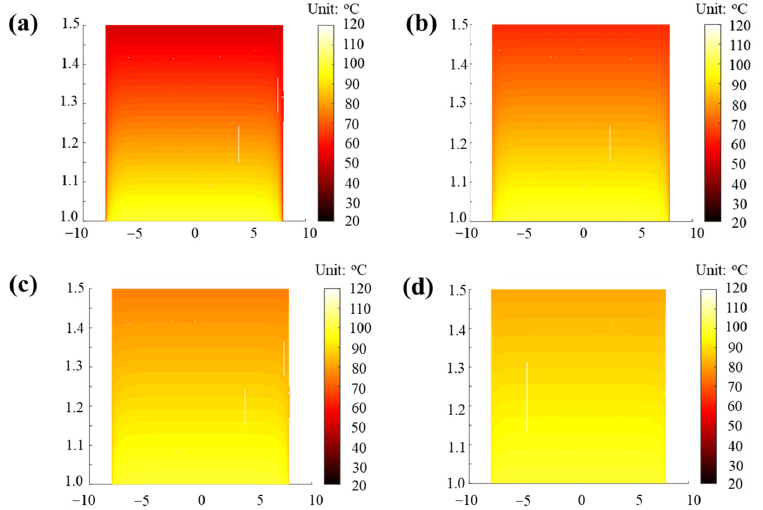
Figure 8. Simulation result of temperature for different cases of thermal conductivity enhancement: ( a ) K = 0.2 W/mK; ( b ) K = 0.3 W/mK; ( c ) K = 0.4 W/mK, and ( d ) K = 0.8 W/mK (the unit of the vertical and horizontal axes is millimeters (mm)).